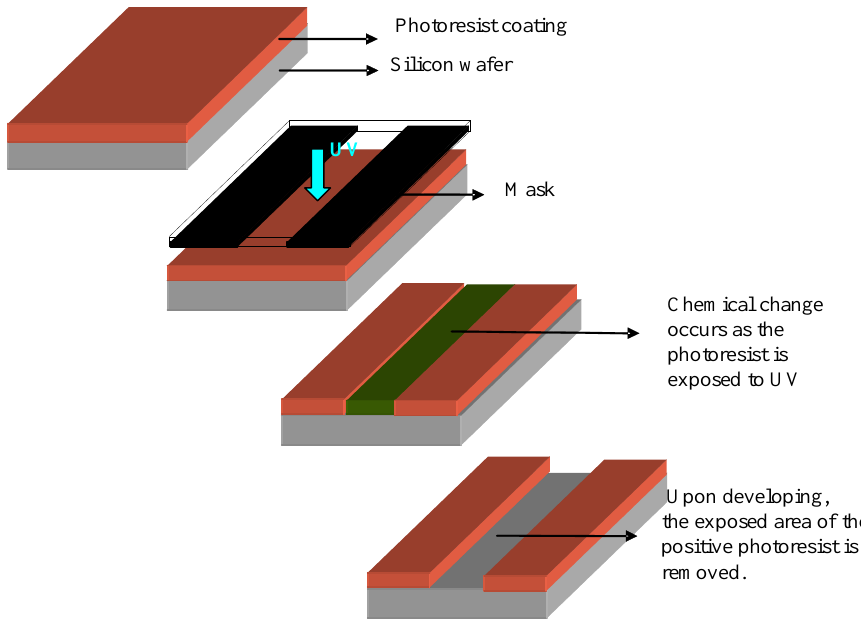
Figure 1. Illustration of MEMS photolithographic